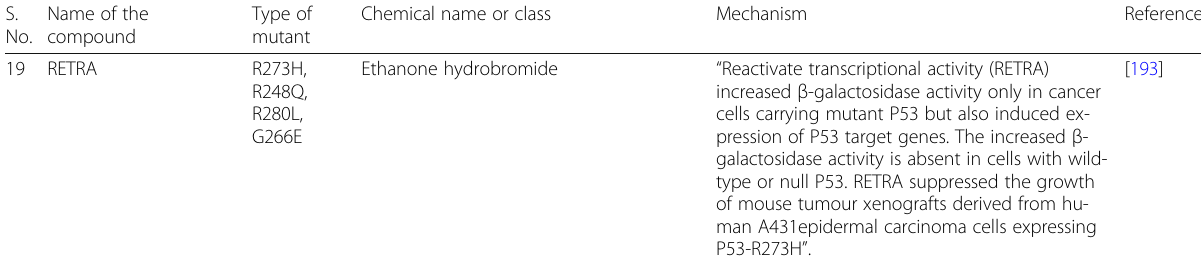
Table 1 Compounds that target mutant P53 and induce reactivation (Continued)